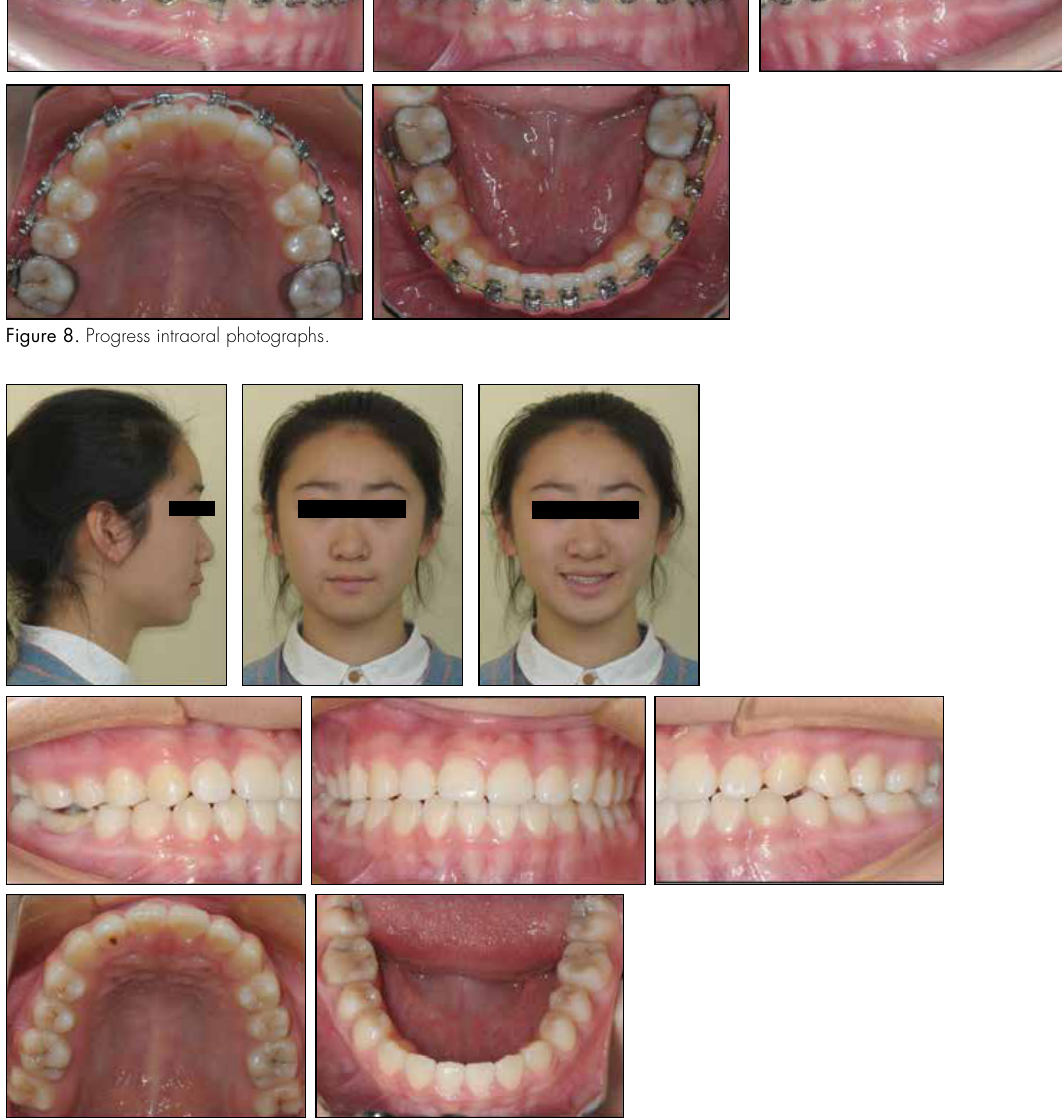
Figure 9. Post-treatment facial and intraoral